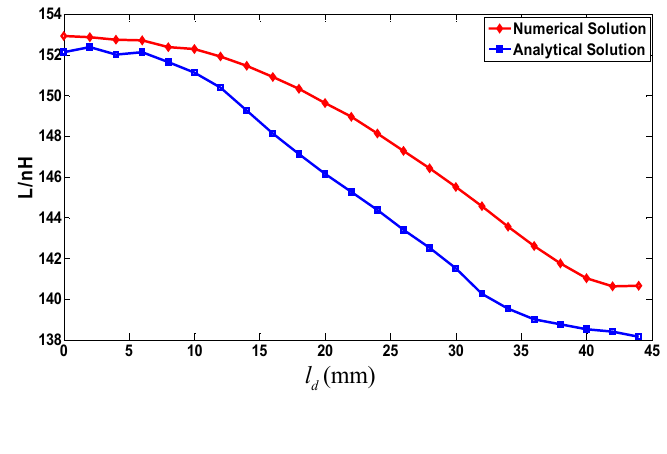
Figure 13. Relationship between coil inductance and relative